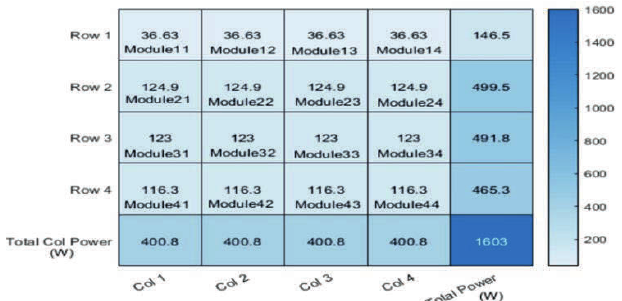
Fig. 9. Initial power of